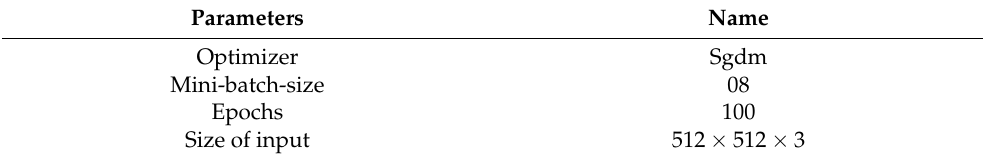
Table 4. Learning parameters.